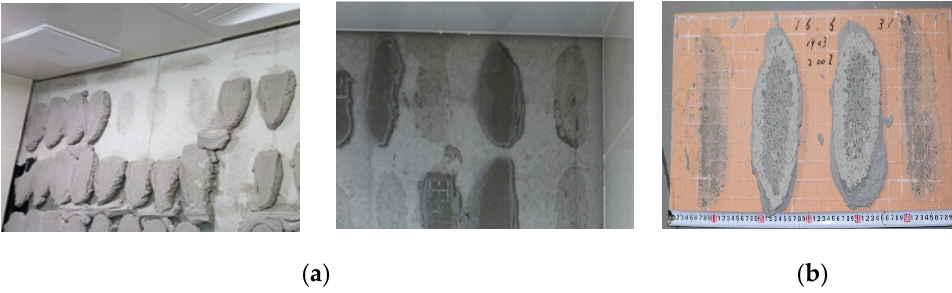
Figure 1. Adhesion failure defects cases in the spot-bonding tiles installation method: ( a ) spot-bonded site defect occurrence; ( b ) rear-side spot-bonding.